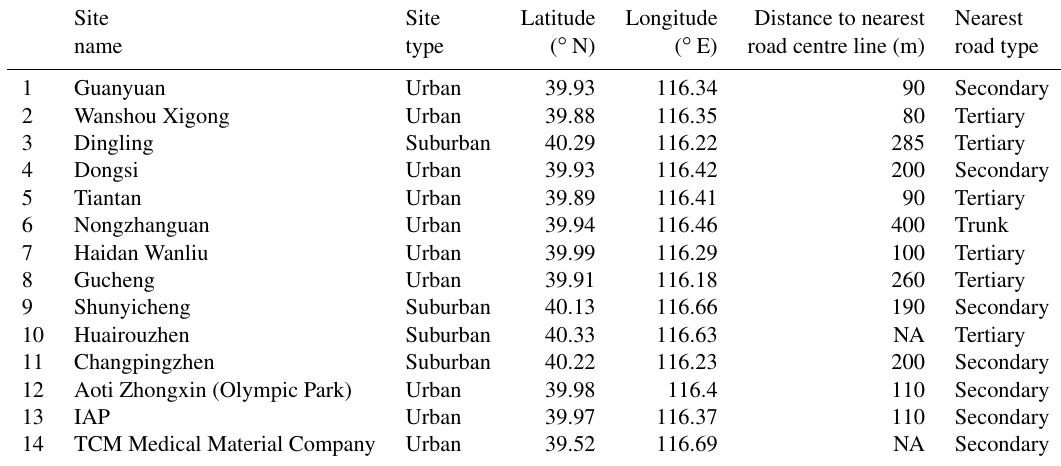
Table 1. Locations (latitude and longitude) of all monitoring stations, including distinction between urban (within the Sixth Ring Road) and suburban site types. The approximate distance (nearest 10m) from each monitoring station to the nearest road centre line and the corresponding road type are also